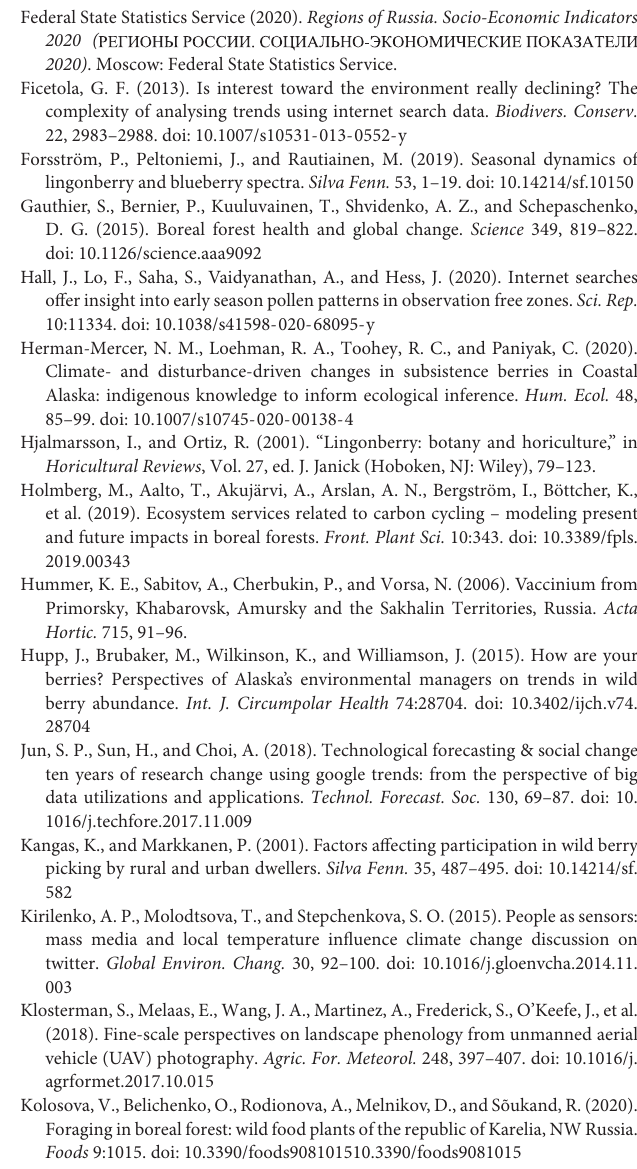
Supplementary Table 2 | Related queries for given keyword (Russian keywords) (search term option) (score > 20). Supplementary Table 3 | Related topics for given keyword with the limited topic “Plants” (search topics option) (score > 20). Supplementary Table 4 | Monthly based related topics for given keyword with the limited topic “Plants” (search topics option). Numbers of the corresponding months are noted in